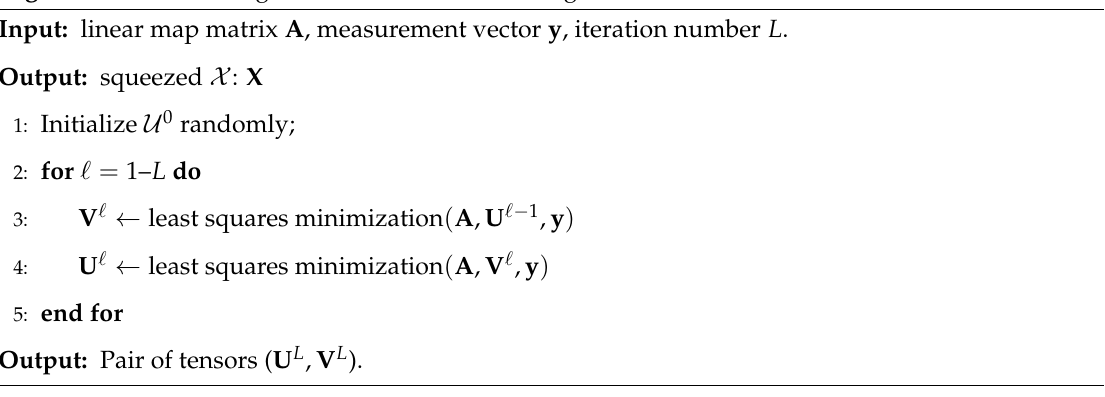
Algorithm 1 Alt-Min algorithm of the tensor sensing.